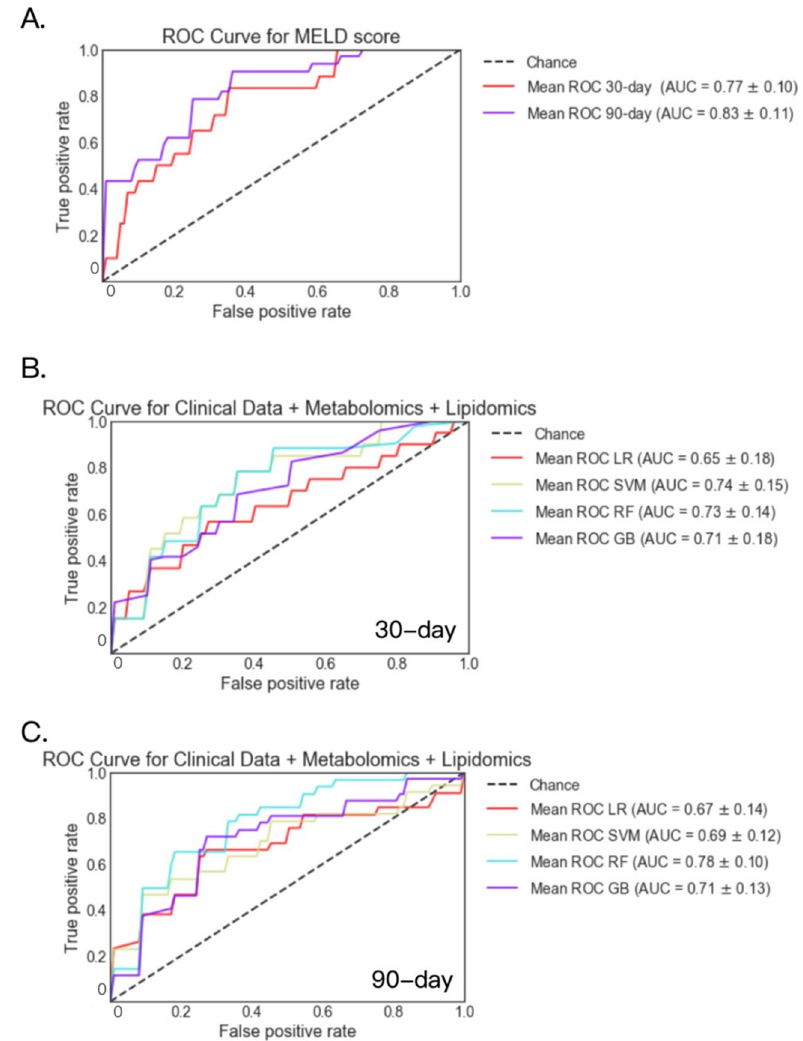
Figure 6. 30- and 90-day mortality prediction using serum metabolites, serum lipids and clinical data in patients with alcoholic hepatitis. ( A ) 30- and 90-day mortality prediction using MELD score. ( B ) 30-day mortality prediction using serum metabolites, serum lipids and clinical data. Deceased group n = 19; alive group n = 99. ( C ) 90-day mortality prediction using serum metabolites, serum lipids and clinical data. Deceased group n = 33; alive group n = 57. GB: gradient boosting, LR: logistic regression, RF: random forest, SVM: support vector machine.